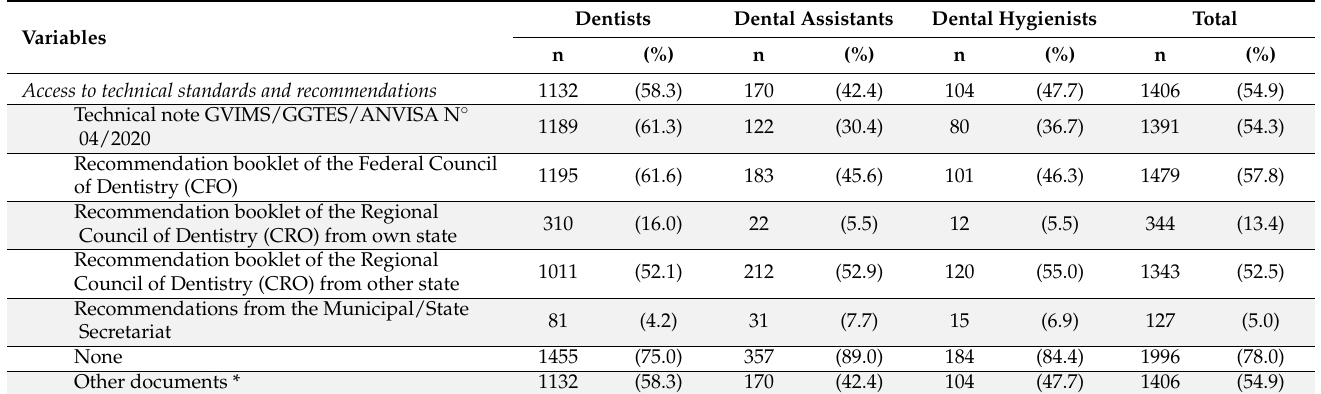
Table 4. Sample of oral health care workers’ distribution regarding the aspects related to